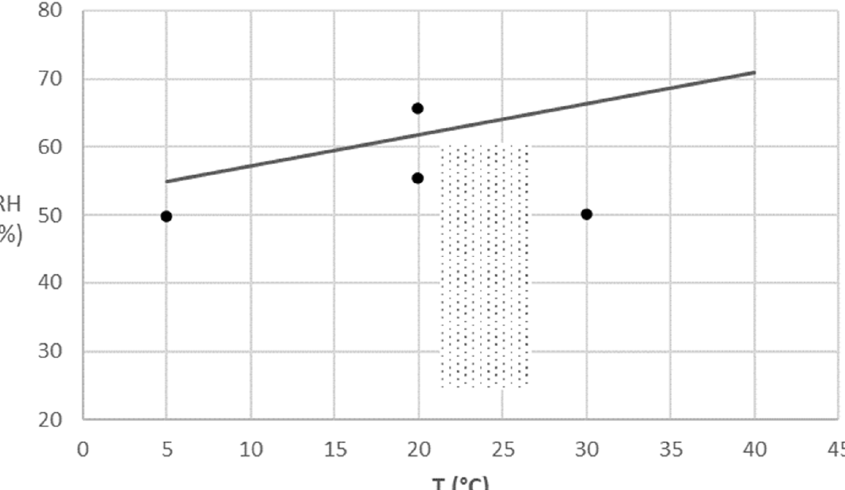
Figure 3. Temperature dependence of maximum relative humidity ( ― ) to achieve a water content of 12.5% (wet basis) on durum wheat pasta based on the desorption curves of De Temmerman et al. [16], with indication of CEN 15251–2007 comfort standards for category II buildings (gray area) and conditions studied in this work (•).